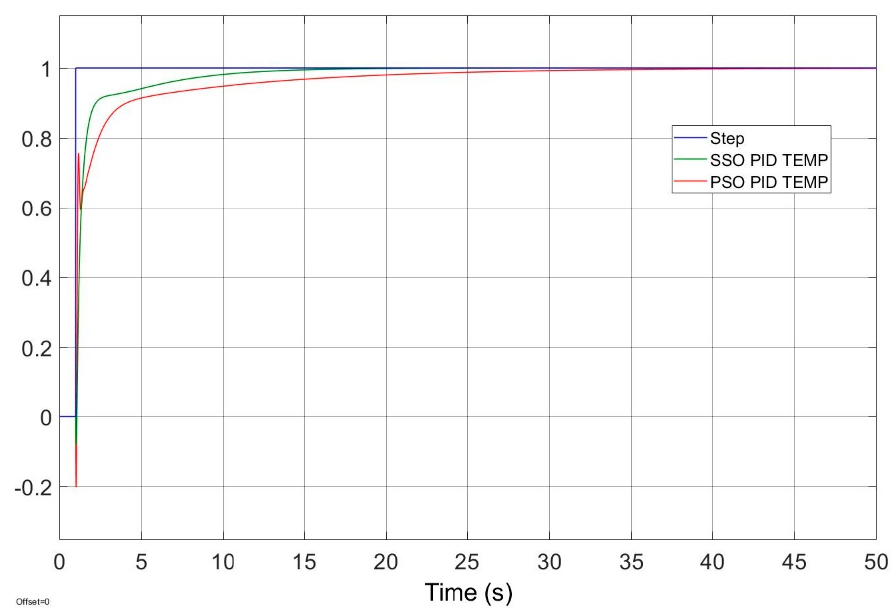
Figure 19. Temperature versus time plot for PID tuned with PSO and SSO.